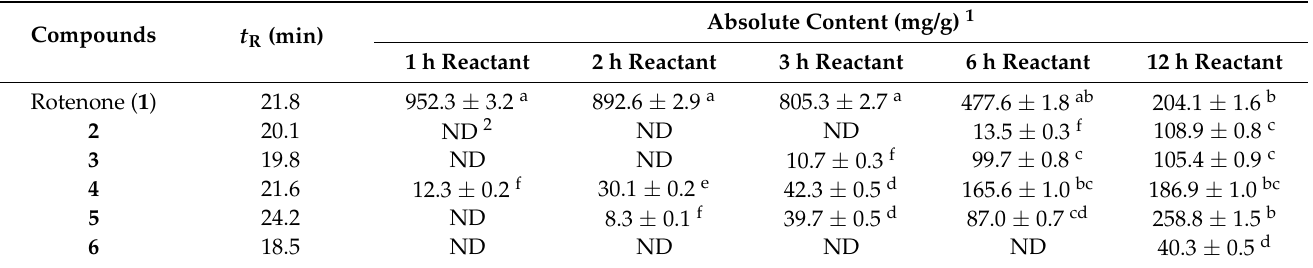
Table 1. Content (mg/g) of individual components in the reaction mixture by thermal treatment